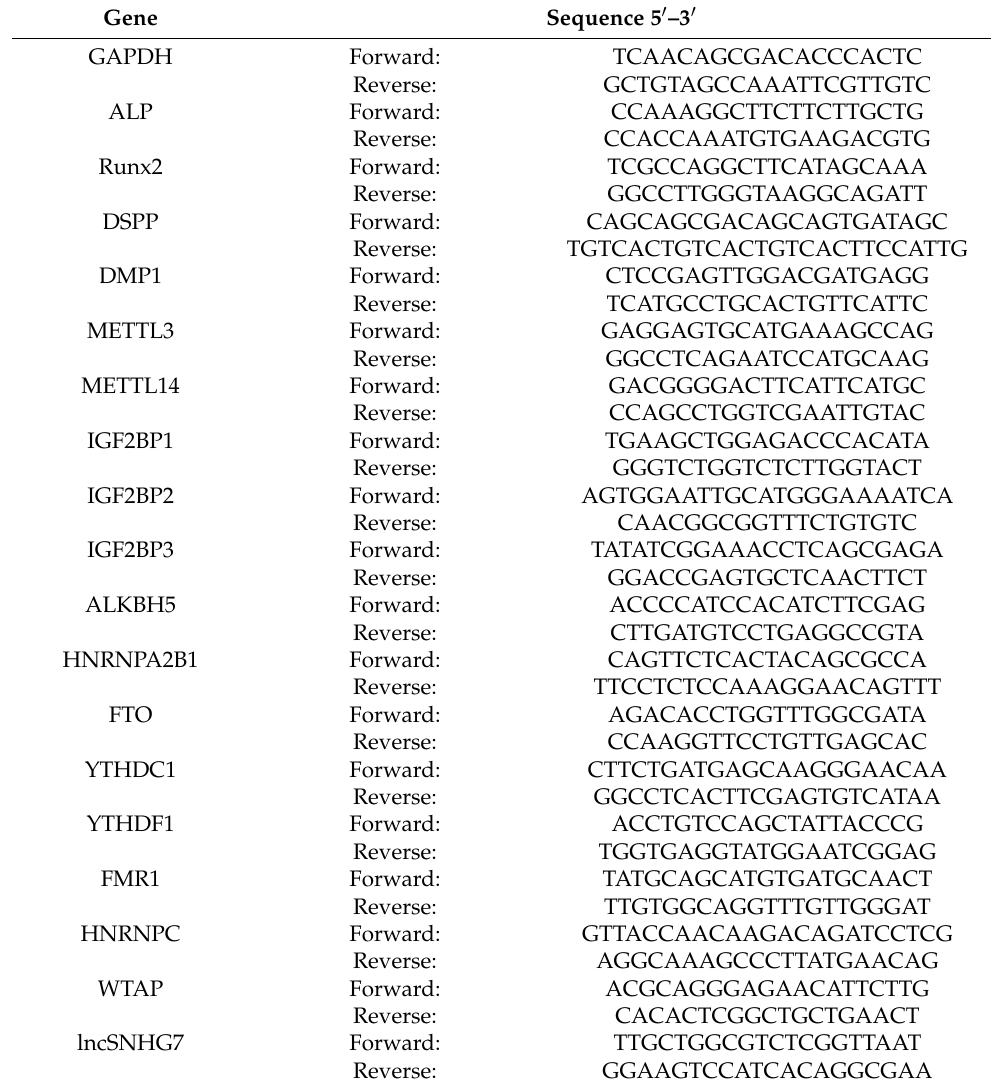
Table 1. The sequences of the primers used in